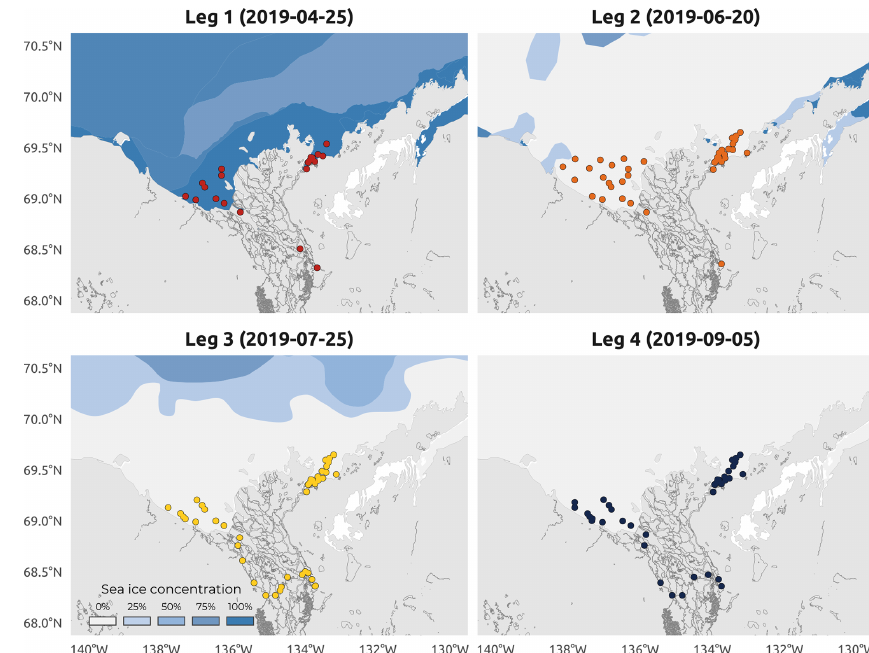
Figure 4. Sea ice concentration (SIC) in the coastal waters of the Beaufort Sea. Colored dots on each panel represent sampled stations during a specific Leg (1–4). Dates represent the middle of the sampling period of each Leg (1–4) of the WP4 Nunataryuk 2019 field campaign. Data are sourced from the National Snow and Ice Data Center (https://nsidc.org/data/G10033, last access: 26 September 2022). Note that there was unconsolidated ice during Leg 2.